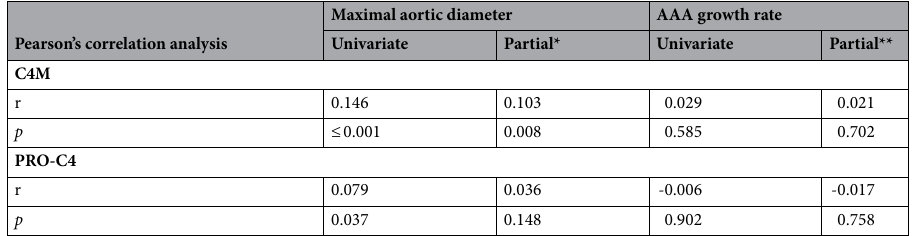
Table 3. Univariate and partial correlation analyses of the plasma C4M and PRO-C4 levels potential associations with maximal aortic diameter and aneurysmal growth rate. *Adjusted for smoking, hypertension, previous ischemic event, statins, and diastolic blood pressure. **Adjusted as above and baseline maximal AAA